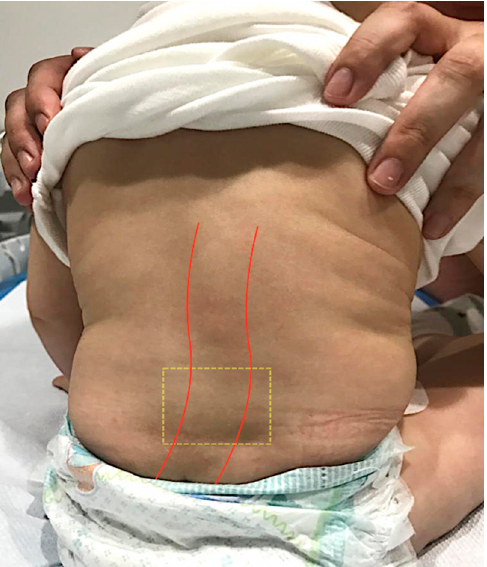
Figure 2. At 8 months after delivery, a physical examination identified a mild scoliosis (red line) and rectangular zone (interrupted yellow line) in front of the transverse process L3–L4.